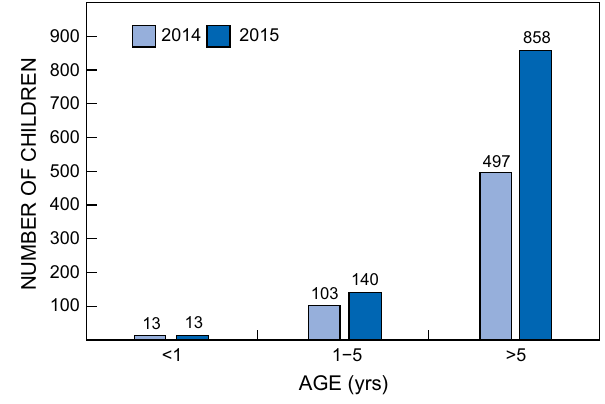
Figure 1: Child ages in the district (2014/2015).